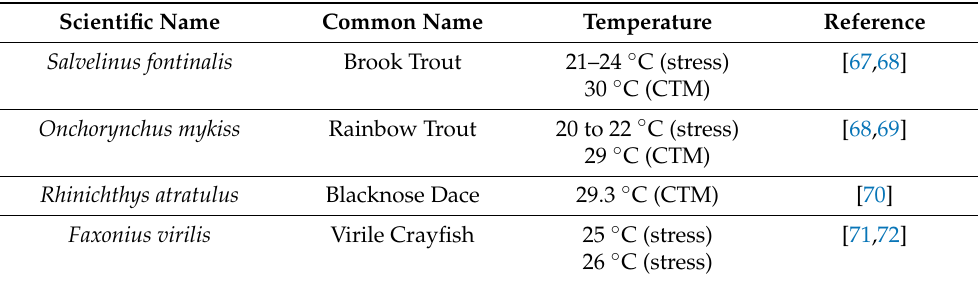
Table 2. Thermal stress and critical thermal maximum (CTM) water temperatures for trout, dace, and crayfish species known to occur at sites for this study.